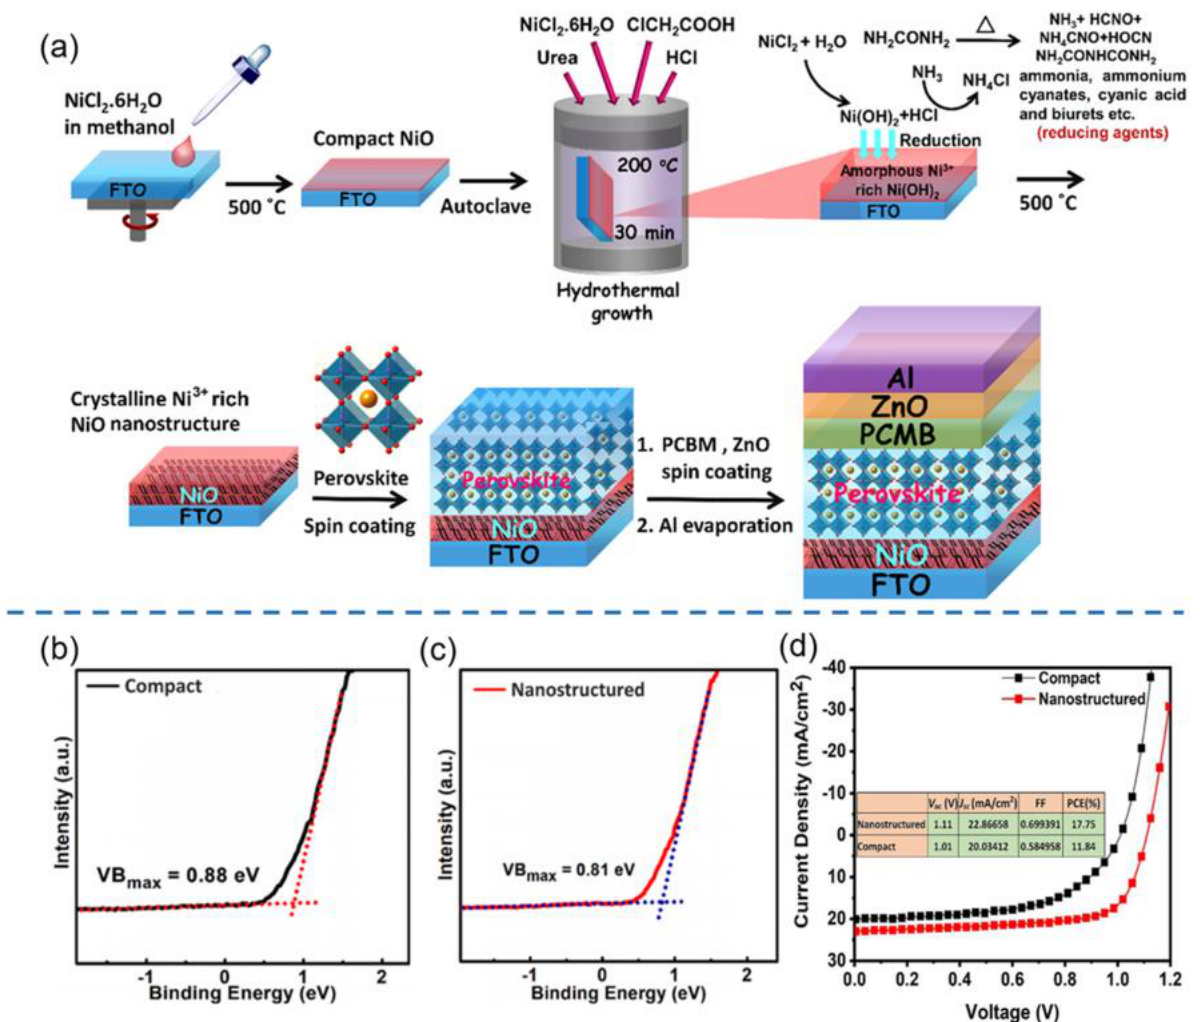
Figure 7. ( a ) Schematic diagrams of the preparation process of Ni 3+ doped NiO by hydrothermal method and corresponding PSCs; the UPS spectra of ( b ) pristine NiO film and ( c ) Ni 3+ -NiO NWs film; ( d ) J–V curves of PSCs with pristine NiO and Ni 3+ -NiO NWs as HTLs. Reproduced from [125], with permission from the ACS Applied Materials & Interfaces, 2020.